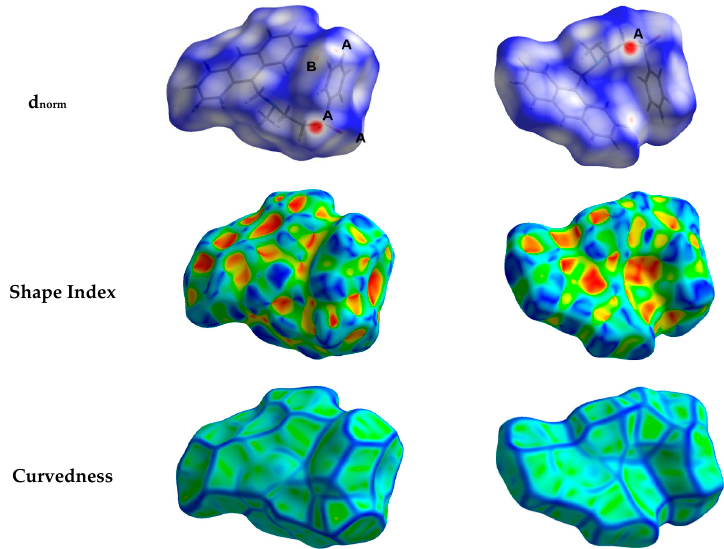
Figure 4. Hirshfeld surfaces mapped over d norm , curvedness and shape index for aza-Michael product 3 . Regions A and B in the d norm maps refer to the strong and weak O…H and C…H contacts, respectively.